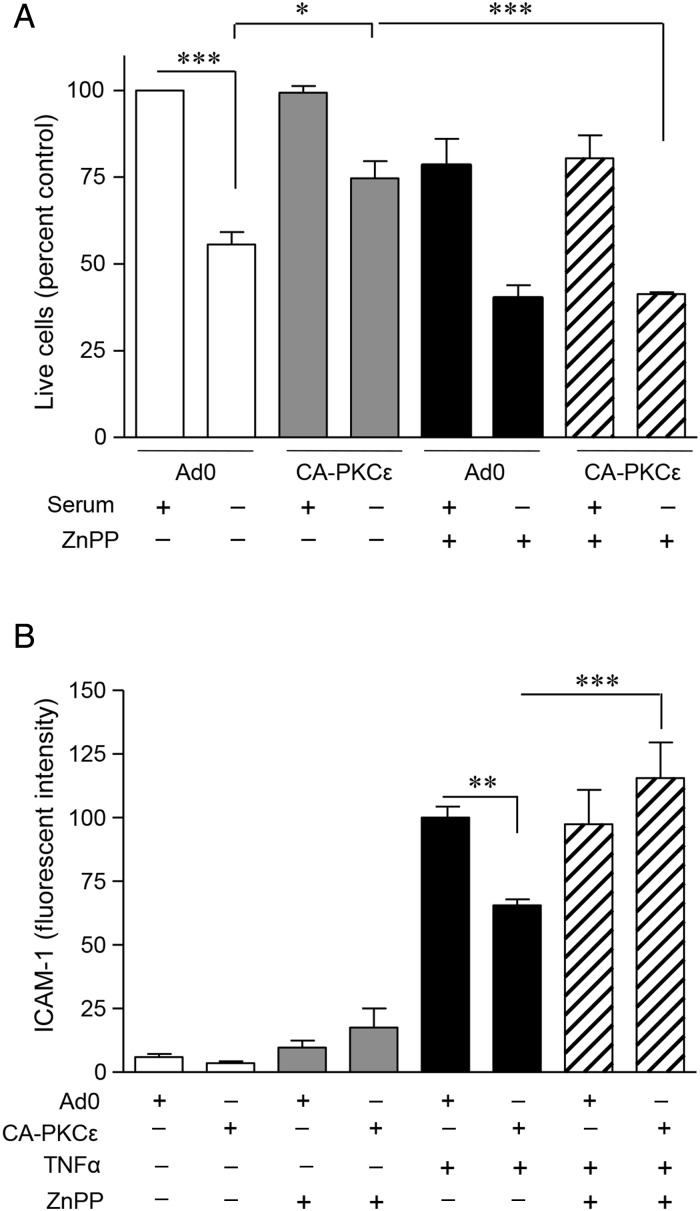
PKCε-induced HO-1 is cytoprotective and anti-inflammatory. (A) HUVECs seeded onto 24-well plates were transfected with CA-PKCε or Ad0 (MOI 100) for 24 h prior to culture in M199/10% FBS or in serum-depleted medium (M199/0.1% FBS), and in the presence or absence of the competitive HO inhibitor ZnPPIX (20 μM) for 24 h. ECs were incubated with MTS reagent in M199/5% FBS for 3 h and samples analysed on a plate reader at 490 nm. Pooled data from three independent experiments are shown. Change in the cell number is expressed as a percentage of the Ad0 control cultured in M199/10% FBS. (B) HUVECs were transfected as above prior to challenge with TNF-α 1 ng/mL for 6 h ± ZnPPIX. ICAM-1 expression was quantified by flow cytometry. Pooled data from four individual experiments are shown; changes in ICAM-1 are expressed as MFI (mean ± SEM) (ANOVA, *P < 0.05, **P < 0.01, ***P < 0.001).